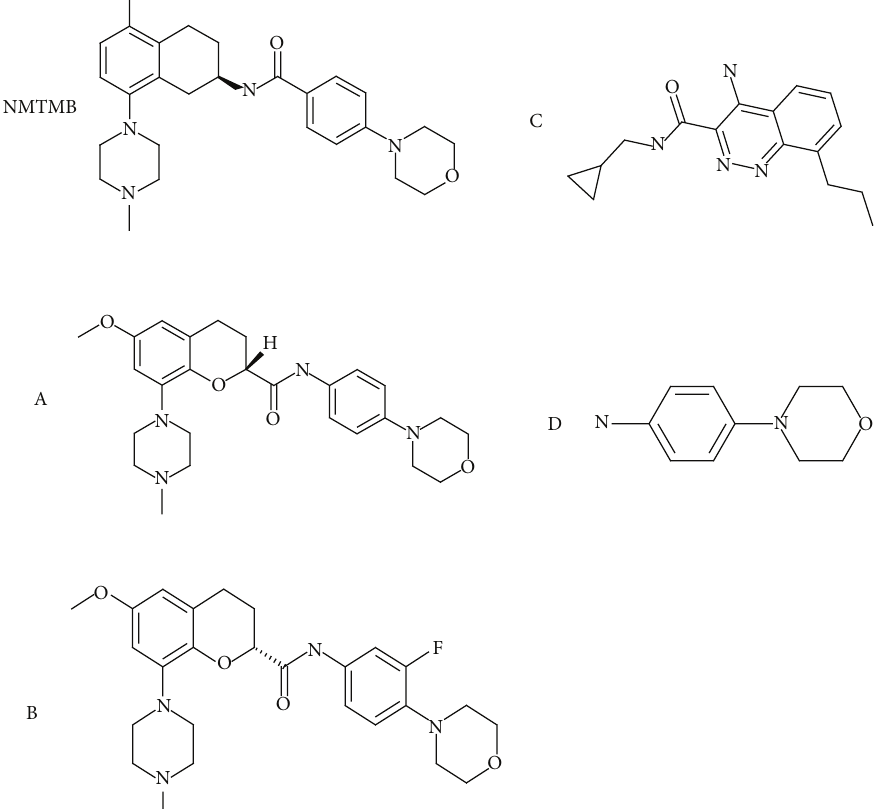
Figure 1: Chemical structures of select compounds used in this